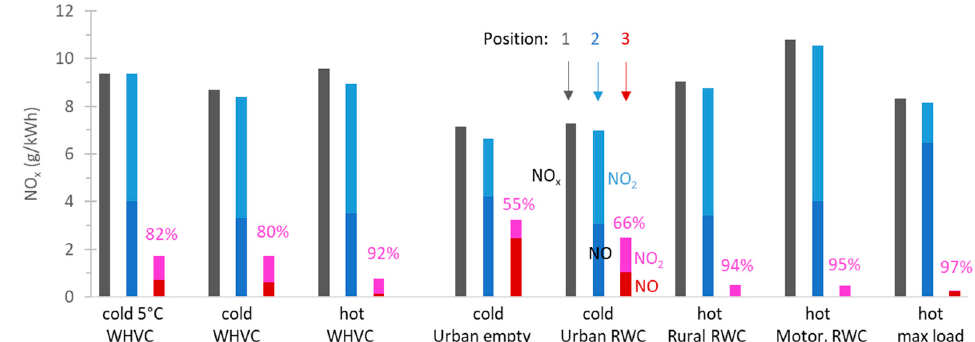
Figure 6. NO x emission factors for various cycles at different sampling positions of the aftertreatment system. When available, NO and NO 2 are given with different color shading. Position 1 (engine out, grey bars); position 2 (DOC + cDPF out, blue bars); position 3 (SCR + ASC out, tailpipe, red bars). Percentages give emissions reductions compared to the previous position. Tests at 23 ◦ C, except “cold 5 ◦ C WHVC”, and 66% of maximum payload, except “Urban empty” (9%). “Cold” and “hot” refer to the coolant temperature at engine cranking, i.e., at ambient temperature or >70 ◦ C, respectively. ASC = ammonia slip catalyst; DOC = Diesel oxidation catalyst; cDPF = catalyzed Diesel particulate filter; RWC = real-world cycle; SCR = selective catalytic reduction; WHVC = world harmonized vehicle cycle.